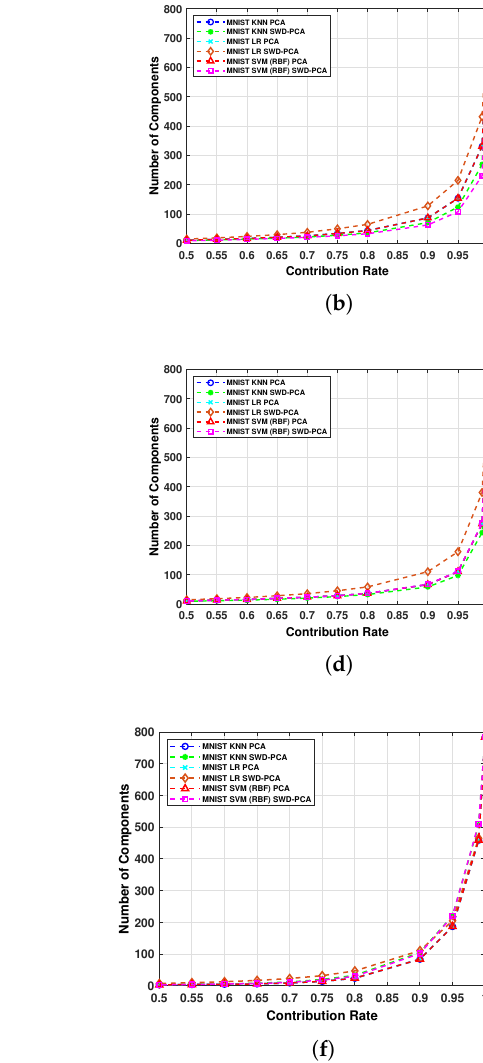
Figure 2. Class-based measurement using accuracy and the number of components. Here, the circle marks indicate the performance when the contribution rate is used. ( a ) Accuracy of MNIST. ( b ) The component of MNIST. ( c ) Accuracy of E-MNIST. ( d ) The component of E-MNIST. ( e ) Accuracy of F-MNIST. ( f ) The component of